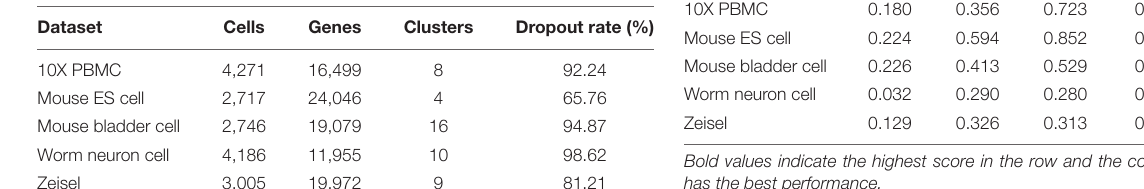
Bold values indicate the highest score in the row and the corresponding method has the best